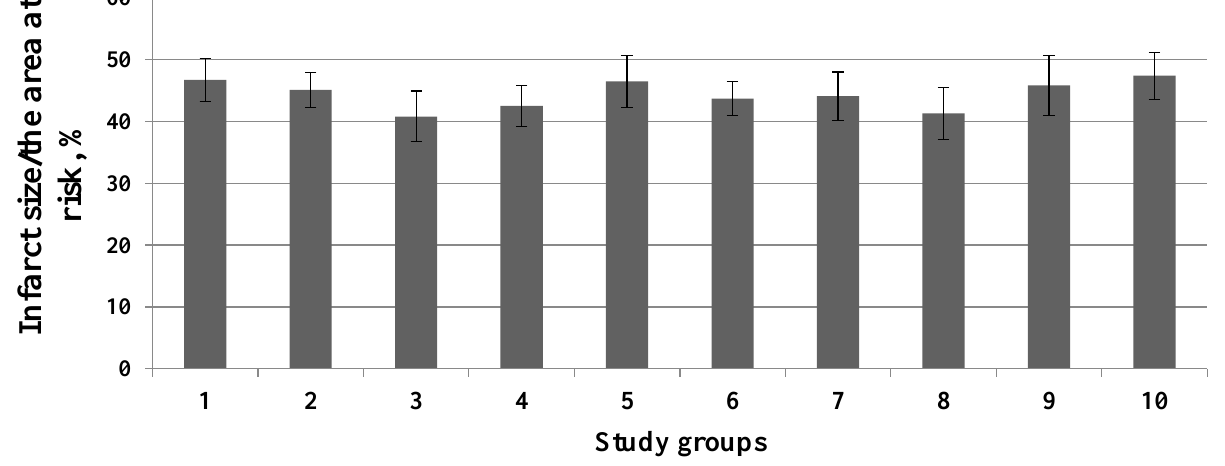
Figure 5. Effect of inhibitors of kinases and molecular structures on the infarct size/area at risk ratio ( Y -axis). 1 — Control; 2 — Chelerythrine; 3 — Rottlerin; 4 — Wortmannin; 5 — PD98059; 6 — H-89; 7 — AG490; 8 — L-NAME; 9 — Compound C; 10 — ODQ. Data represent the means ± SEM. Each study group included 12 rats.